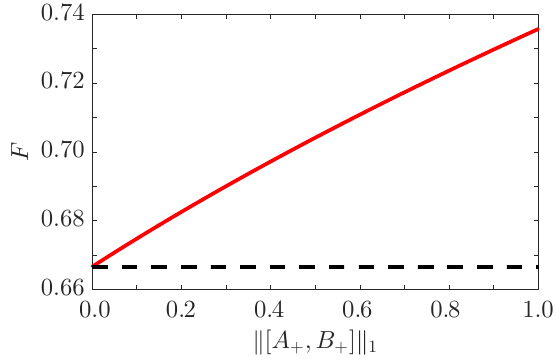
FIG. 4. Relation between the two-copy estimation fidelity and the commutator of POVM elements. Here F = F ( A ⊗ B ) is the estimation fidelity achieved by the tensor product of two rank-1 projective measurements as shown in Eq. (84), while (cid:20) (cid:20) [ A + , B + ] 1 is the 1-norm of the commutator [ A + , B + ]. As a benchmark, the black dashed line denotes the one-copy estima- tion fidelity achieved by a rank-1 projective